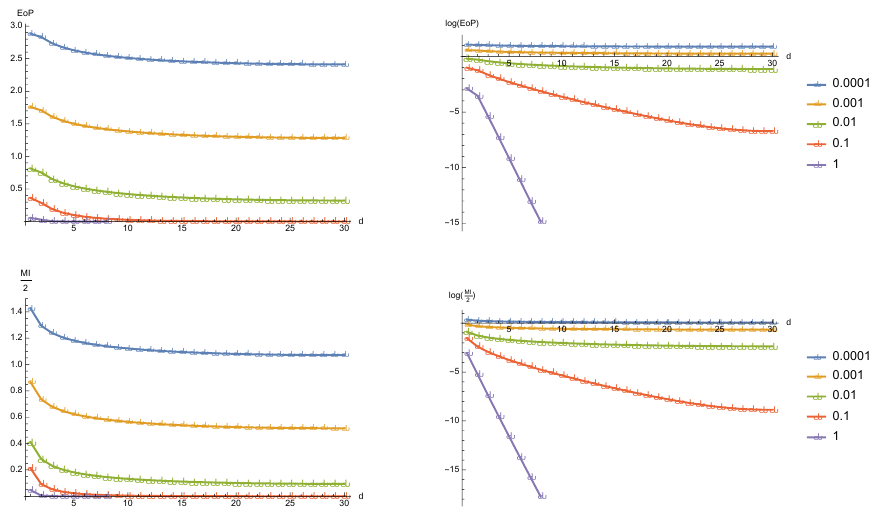
Figure 8 . The plots of EoP (upper graphs) and a half of mutual information I ( A : B ) (lower graphs) as a function of d in the setup of j A j = 1 ; j B j = 2. The right ones are obtained